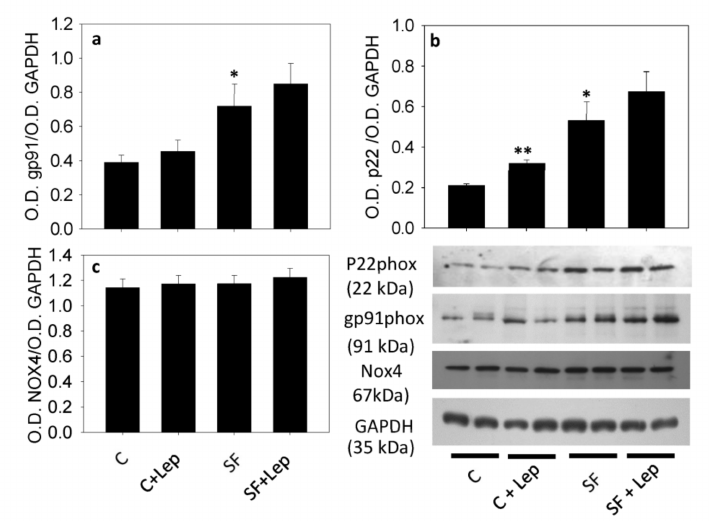
Figure 3. Analysis by western blot of Nox subunit proteins in aortic SMC. The subunits p22phox (22 kDa), gp91phox (91 kDa) and Nox4 (70 kDa) were detected in aortic SMCs from C and SF rats and in cells treated with leptin at 40 ng/mL culture medium for 24 h. At the end of the experiment cell were lysed and proteins were quantified according to Bradford as described in Methods section. Fifty µ g protein of sample was loaded into an SDS-PAGE gel with 10% of the acrylamide for and Nox4 (70 kDa and gp91phox (91 kDa) and with 12% for p22phox (22 kDa). The graphs correspond to the ratio of optical densities (O.D.) of the above-mentioned proteins to the O.D. of GAPDH used as a control load. The panel ( a ) corresponds to the subunit gp91phox, the panel ( b ) corresponds to p22phox and the panel ( c ) corresponds to Mox4. The values correspond to the mean ratio of optical densities +/ − SD (n = 4 different experimental animals).* p < 0.05 corresponds to C vs. SF, ** p < 0.005 corresponds to C vs. C + Lep.